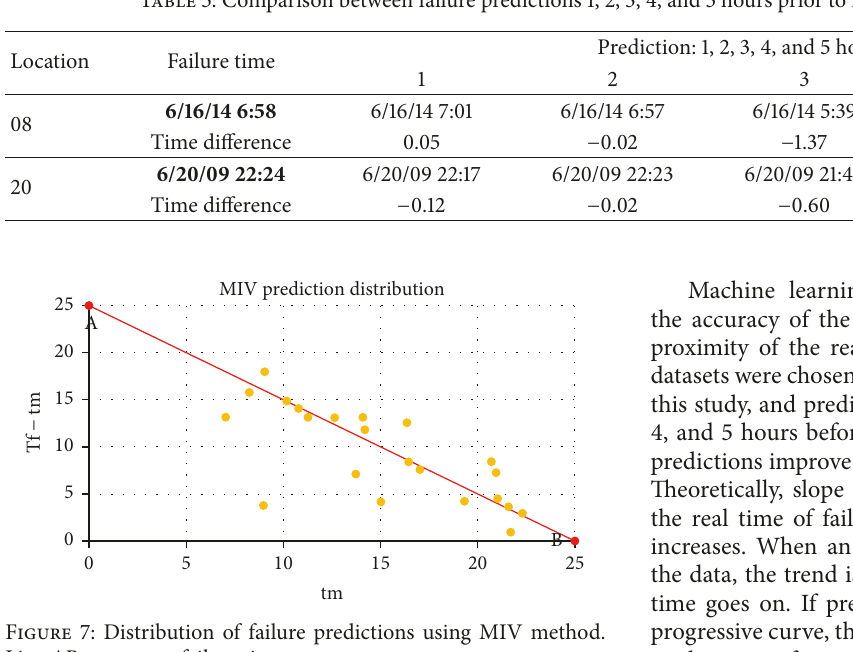
Table 5: Comparison between failure predictions 1, 2, 3, 4, and 5 hours prior to failure for locations 8 and 20.